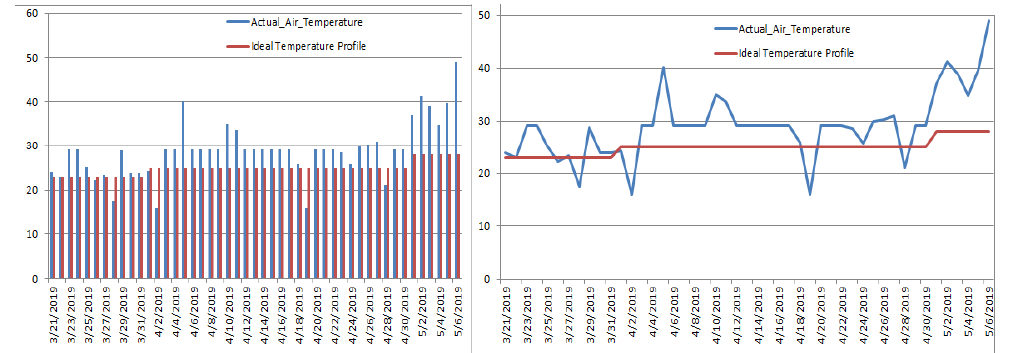
Figure 5. Deviation of observed temperature from the ideal temperature